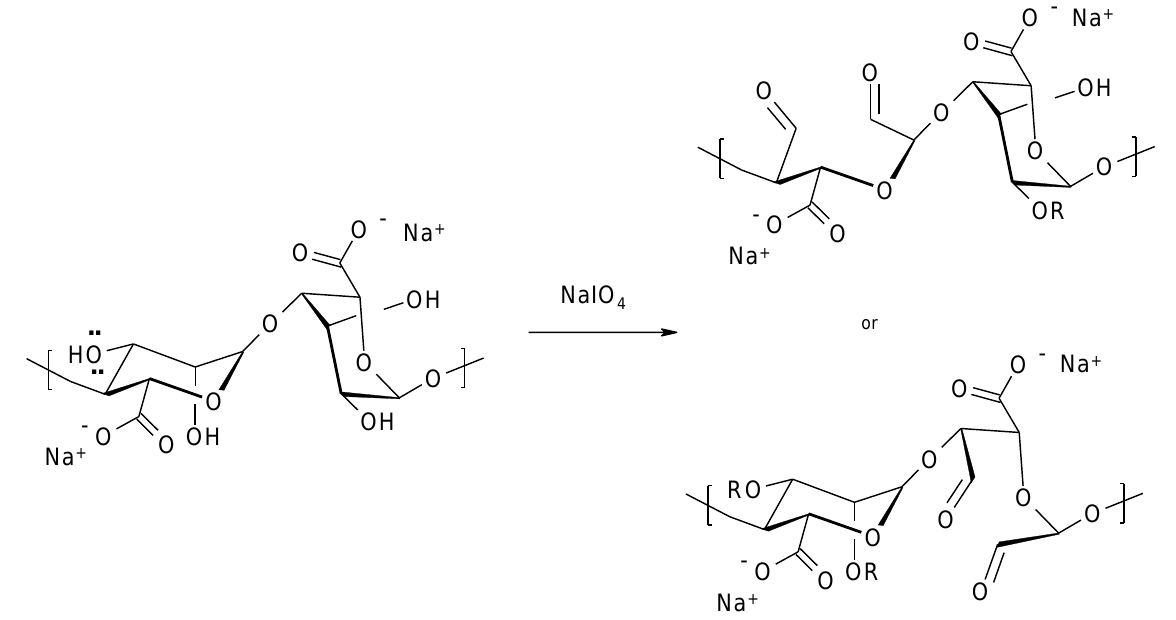
Figure 11. Oxidation of sodium alginate.